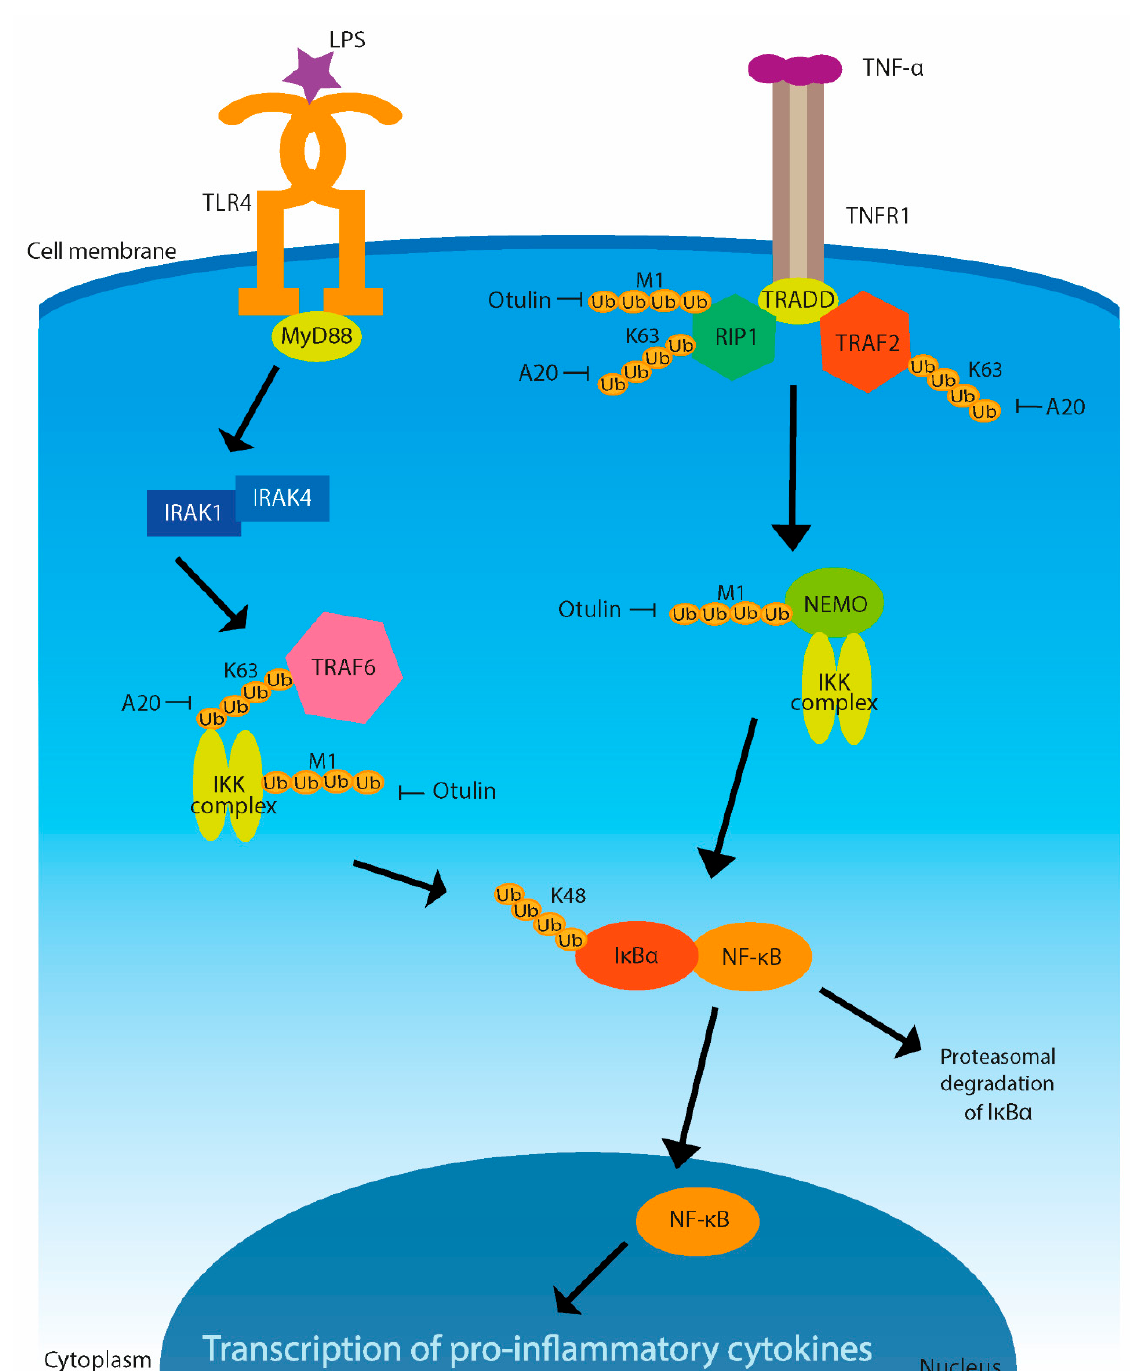
Figure 3. Activation of innate immune signaling pathway by lipopolysaccharide (LPS) and tumor necrosis factor (TNF). LPS is bound by toll-like receptor 4 (TLR4), and then adaptor protein MyD88 interacts with IRAK protein kinases. Recruitment of IRAK complex results in association with another adaptor protein, TRAF6, and this leads to I κ B kinase (IKK) activation. NF- κ B is a functional transcription factor after I κ B α phosphorylation and subsequent dissociation of the complex of NF- κ B and I κ B α . I κ B α , an inhibitor of NF- κ B, can also be degraded by way of ubiquitination. Ubiquitinated I κ B is degraded in proteasome and NF- κ B moves to the nucleus, where it activates the proinflammatory cytokine transcription. A different way of activating the NF- κ B pathway shown here is through binding of TNF by TNF receptor 1 (TNFR1). Adaptor protein TRADD recruits receptor-binding protein 1 (RIP1) and TNFR-associated factor TRAF2. RIP1 activates IKK complex and thus also NF- κ B pathway. It is shown that A20 and otulin interact with Ub chains in the signaling pathway.